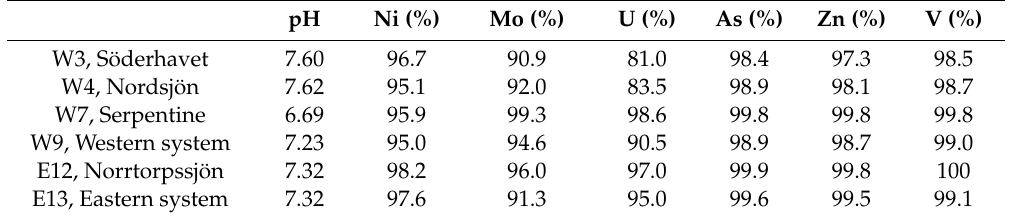
Table 11. Immobilization (%) of the potentially released trace elements from the solid waste in the area. Primary release rates based on the trace elements / sulfate ratios ( µ g / L / mg /